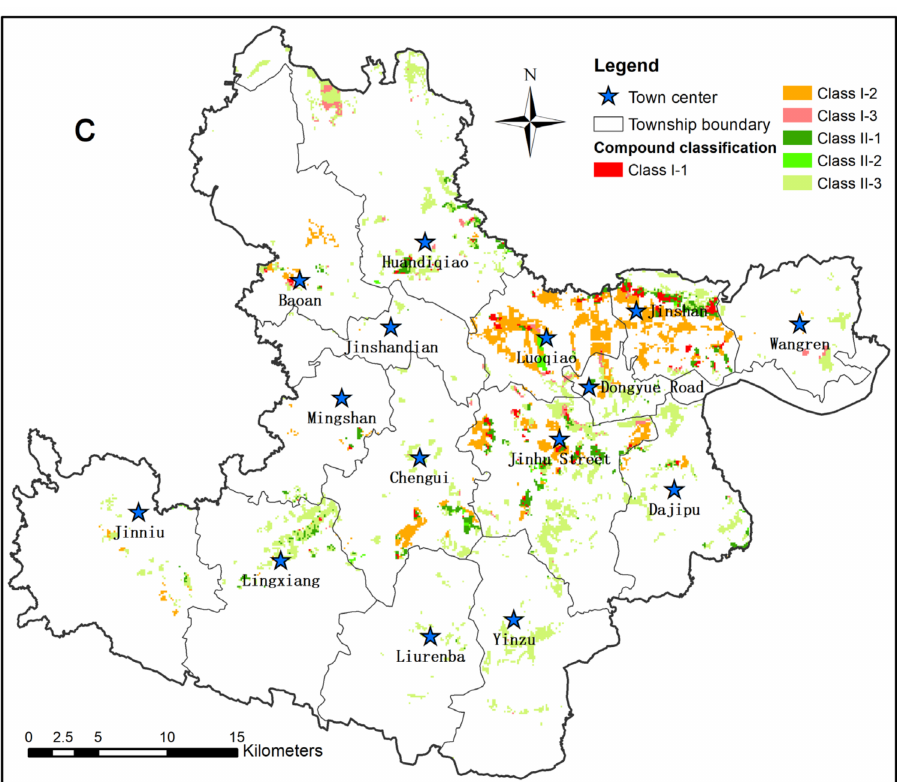
Figure 5. ( a ) The manifestations of key conflicts and their spatial distribution. ( b ) The spatial distribution of key conflicts of different dominant factors. ( c ) The classification and distribution characteristics of key conflict